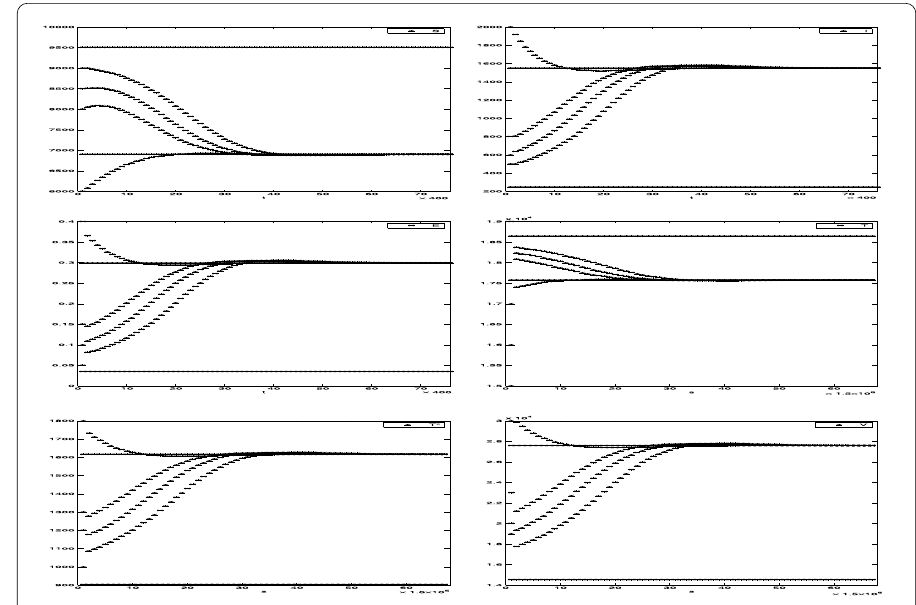
Figure 2 The trajectories of solutions ( S ( t ), I ( t ), E ( t ), T ( s ), T ∗ ( s ), V ( s )) with initial values ( S (0), I (0), E (0), T (0), T ∗ (0), V (0)) = (8500,600,0.15,15,000,1000,8500),(8000,800,0.1,16,000,1200,23,000), (6000,2000,0.4,19,000,1800, 30,000) and (9000,500,0.05,17,000,1300,19,000)